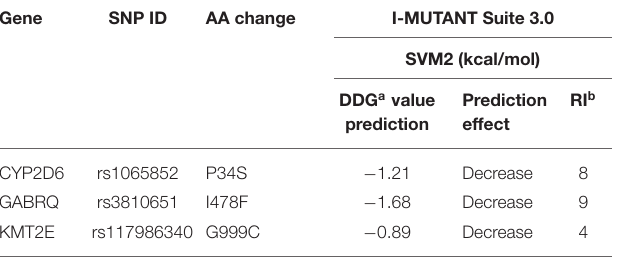
TABLE 3 | Protein stability changes after amino acid substitution for nsSNPs predicted by I-MUTANT. Gene